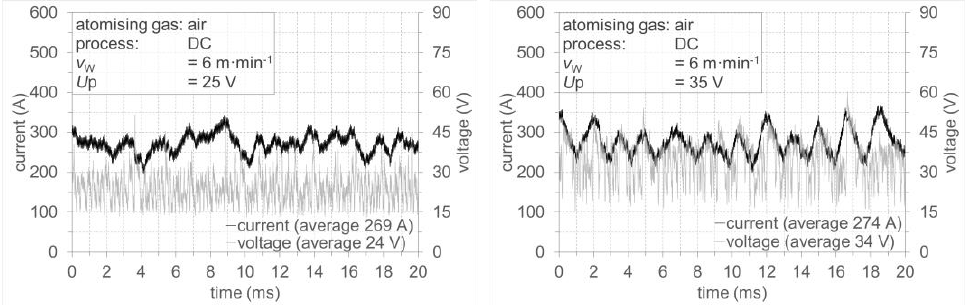
Figure 10. Current/voltage curve, direct current, ( left ): U = 25 V, ( right ): U = 35 V.